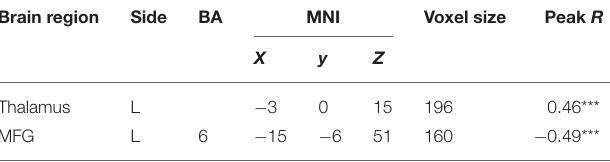
TABLE 3 | Significant associations between brain regions and the